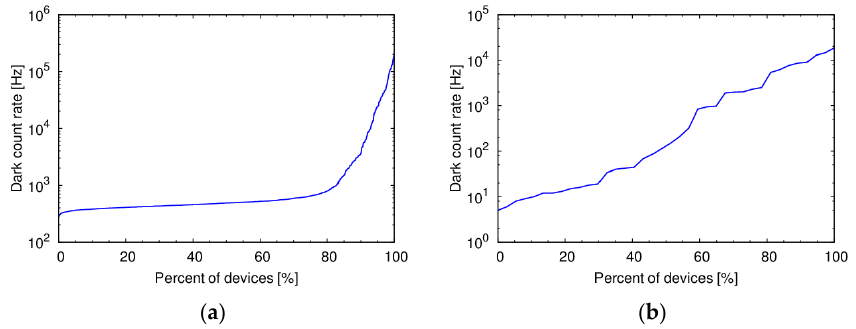
Figure 2. Dark Count Rate distribution of SPADs fabricated in different CMOS process technologies ( a ) 0.35 µm High Voltage with 130-µm 2 active area [19]; ( b ) 0.7 µm High Voltage with 100-µm 2 active area [11].